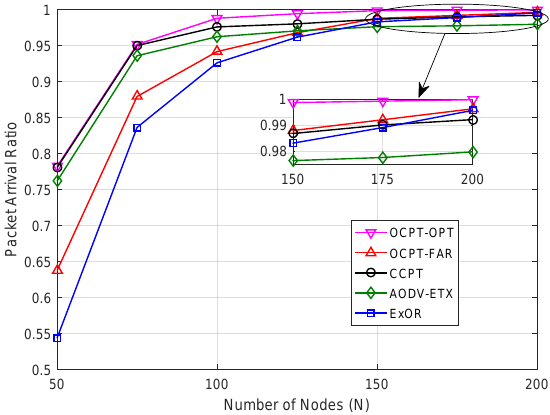
Figure 5. Packet arrival ratio vs. number of nodes with different schemes under the random V s and V d